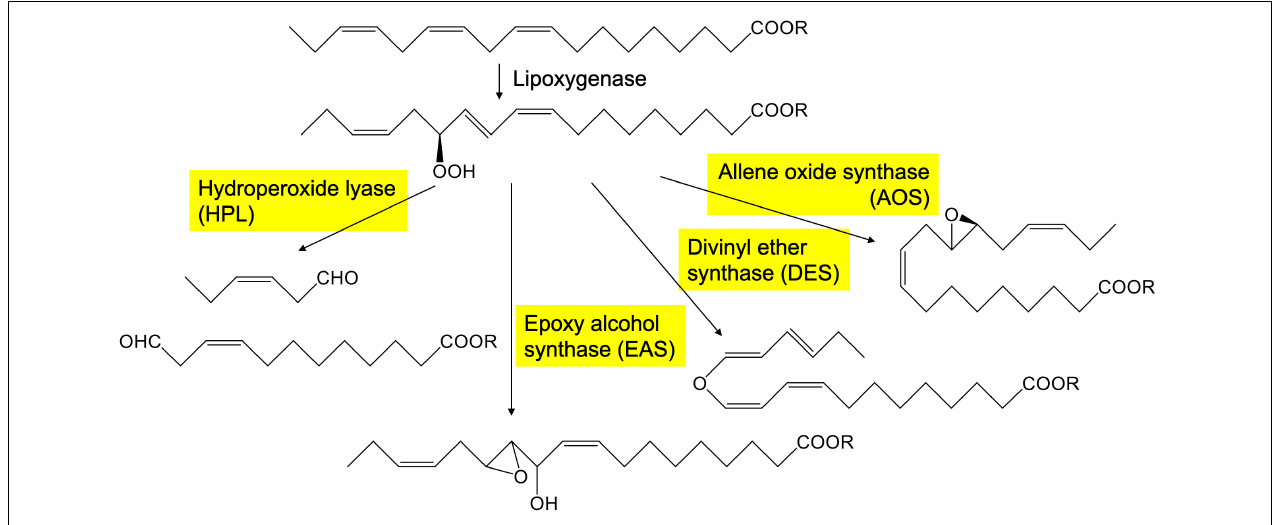
FIGURE 1 | Representative pathway to form oxylipins from 13-hydroperoxide of linolenate catalyzed by CYP74s in plants. The enzymes with yellow background belong to CYP74